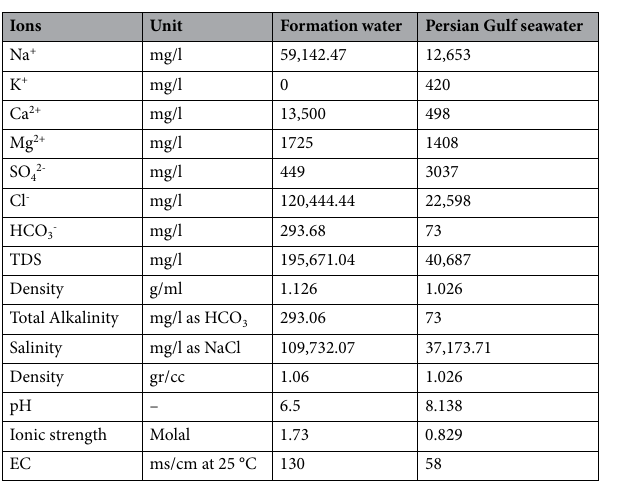
Figure 1. Schematic diagram of the workflow.